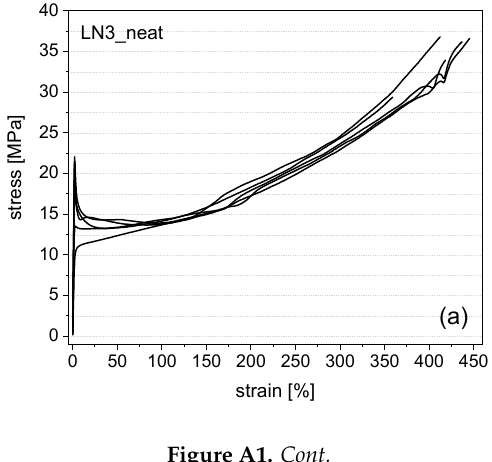
Figure 11. Mechanical characteristics of LN3 and LN3/MWCNT composites evaluated from tensile tests: ( a ) Young’s modulus, ( b ) Yield stress, ( c ) strain at break, and ( d ) tensile strength